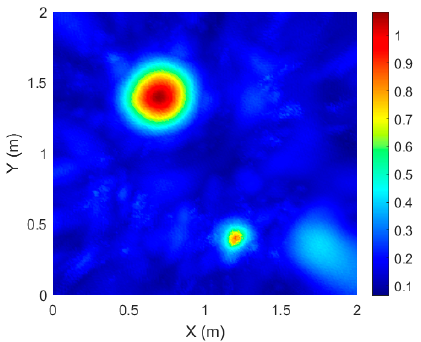
Figure 6. Preliminary beamforming map by DAS.